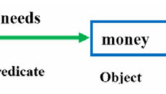
Figure 21. An example for a triple: ‘He needs